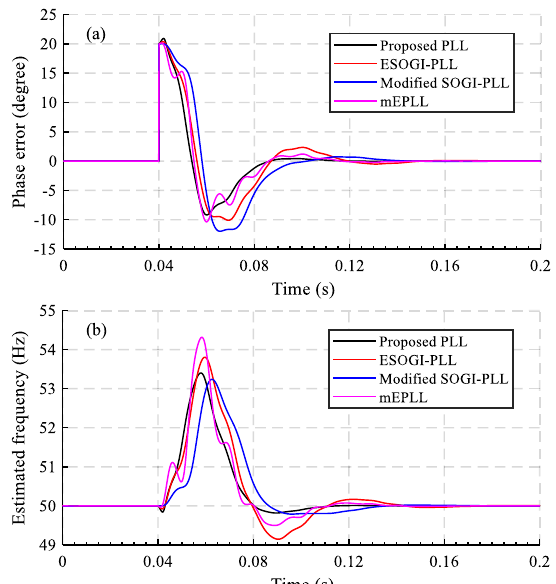
Fig. 8 Performance comparison between the proposed PLL, ESOGI-PLL, modified SOGI-PLL, and mEPLL under Case 2 (a phase jump of 20° and a DC offset of 0.15 pu added to the grid voltage at 0.04 s). a Estimated phase error and b estimated grid frequency